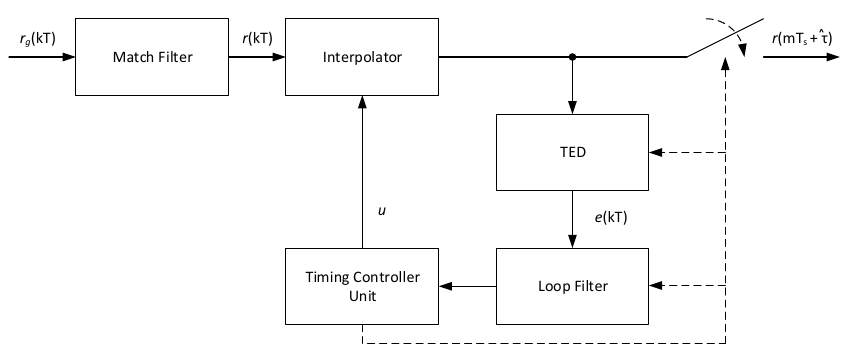
Figure 1. Feedback timing architecture.